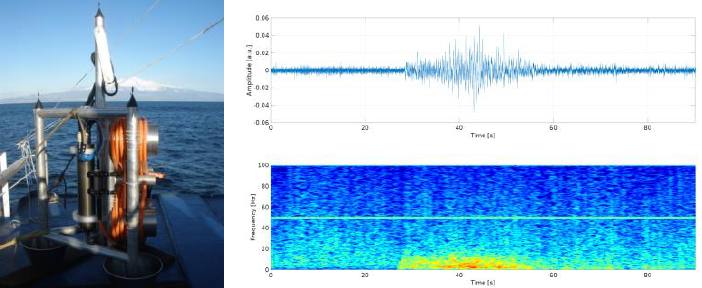
Figure 3. Left: The SMO-O  DE real-time acoustic observatory, deployed in 2012 at 2100 m depth offshore Catania. The detector is still properly working. Right: Acoustic signature of an earthquake originated by the Etna volcano (M=4.8), recorded October 6 th , 2018. Top panel oscillogram, bottom panel